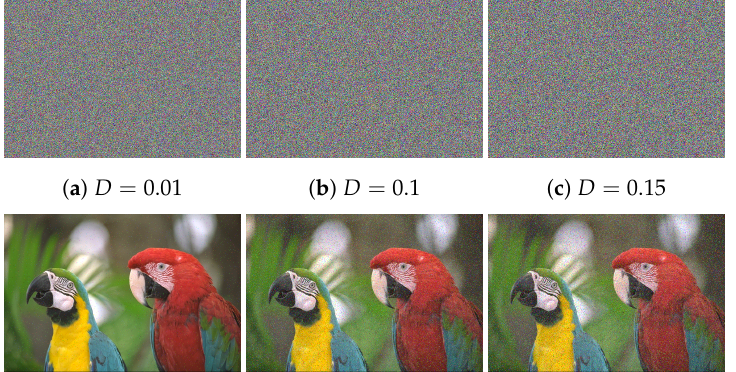
Figure 17. Outcomes of noise attack, in which the top row refers to the defective Cipher–Macaws image by adding Salt and Pepper noise with variable densities ( D ) while the bottom row represents the corresponding decipher image.